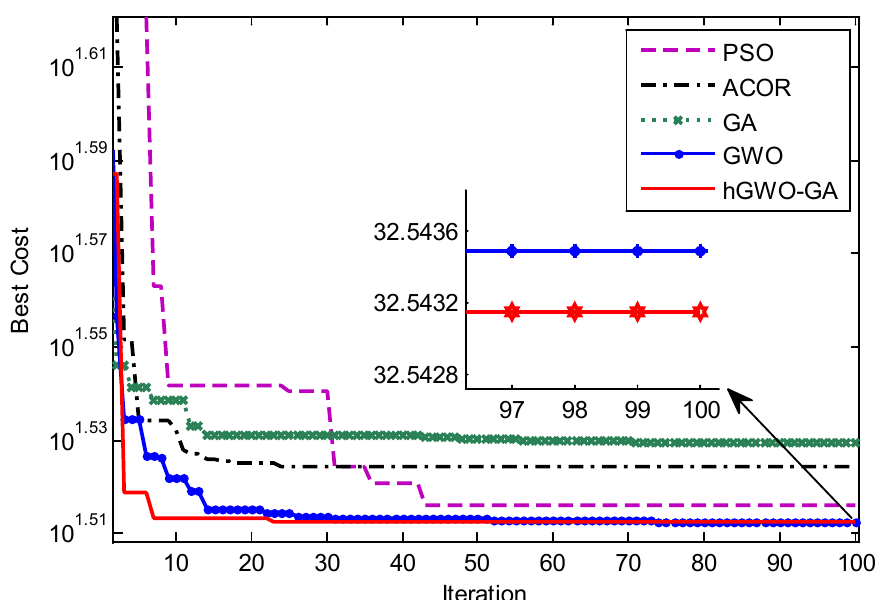
Figure 11. Fitness convergence for robust solution ( φ -based stabilizer).